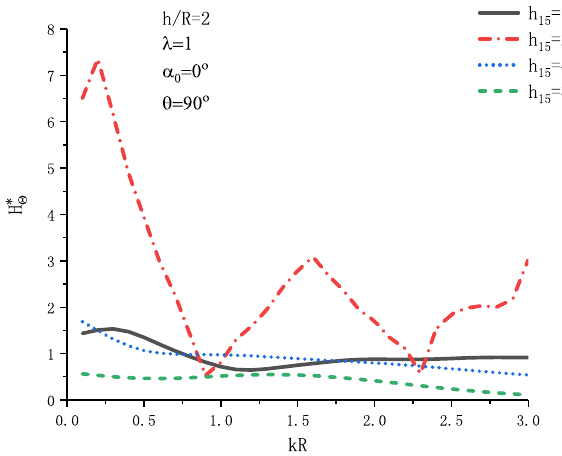
* kR when SH wave incident horizontally ( h 15 ). θ vs.